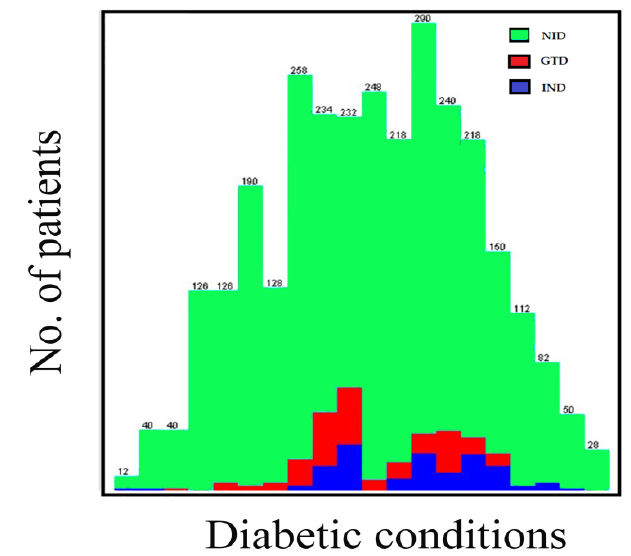
Figure 5. Patients age distribution based on diabetic conditions.